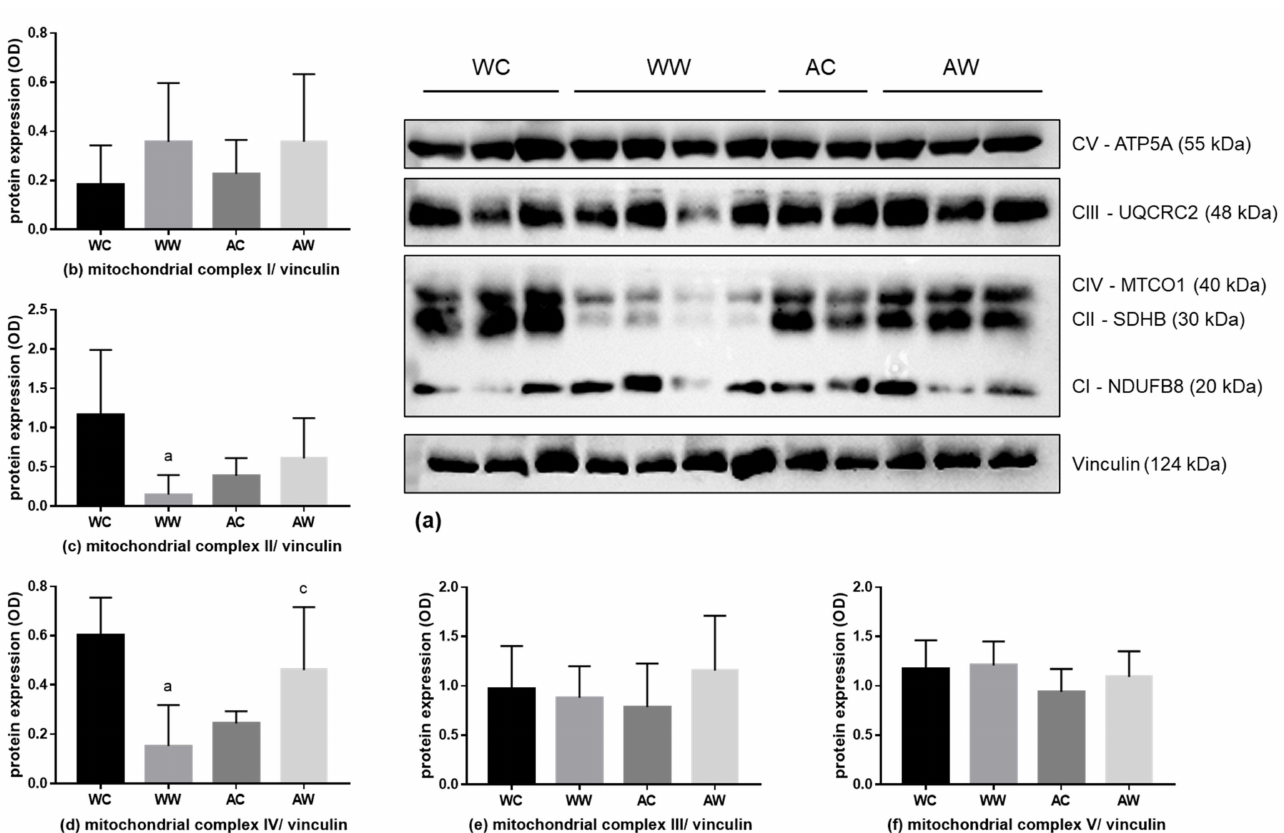
Figure 4. Liver protein expression of the mitochondrial respiratory complex. ( a ) Western blot images are a representative image of the mitochondrial respiratory complexes and the loading control vinculin of the total analysis of all animals in each group. Analyses of the protein expression of mitochondrial respiratory complexes; the subunits protein expression are presented in ( b ) V subunit; ( c ) III subunit; ( d ) IV subunit; ( e ) II subunit; and ( f ) I subunit. For subunit details, please see the Material and Methods section. Legend: WC, weanling control group ( n = 7); WW, weanling tumour-bearing group ( n = 10); AC, adult control group ( n = 6); AW, adult tumour-bearing group ( n = 8). Data were expressed as mean ± standard deviation (SD). The units used were protein/vinculin protein expression (optical density, OD—western blot image). Data were analysed by two-way ANOVA and corrected for multiple comparisons by the post hoc test Bonferroni. a represents differences from the WC group and c indicates differences from the WW group. Differences were significant when p <